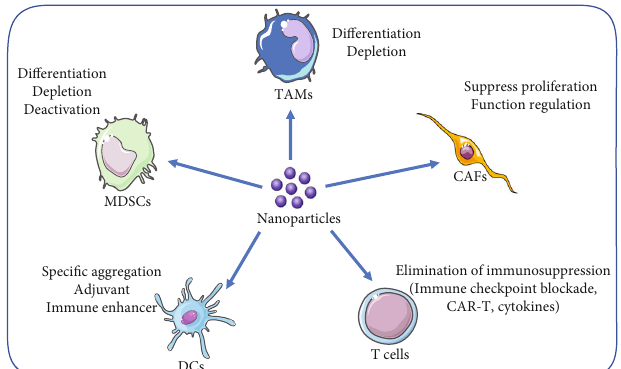
Figure 3: Some strategies of biomaterials in targeting di ff erent cells in a tumor immune microenvironment. Nanoparticles can target immune cells in TIME, including tumor-associated macrophages (TAMs), myeloid-derived suppressor cells (MDSCs), dendritic cells (DCs), T lymphocyte cells (T cells), and cancer-associated fi broblasts (CAFs), through various pathways or methods enumerated as